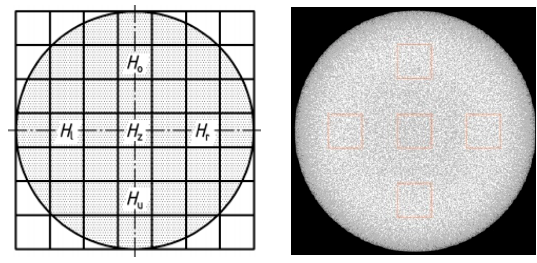
Figure 4. Delineation of the region of interest.